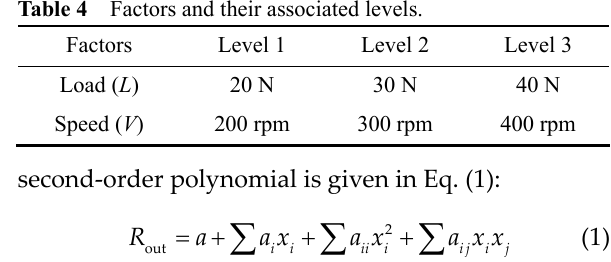
Fig. 23 Response surface plots of (a) core roughness depth ( S k ), S = 0.64, R -sq = 97.8%, α = 0.05, R -sq (adj.) = 94.13%; (b) RMS slope ( S dq ), S = 0.014, R -sq = 98.43%, α = 0.05, R -sq (adj.) =